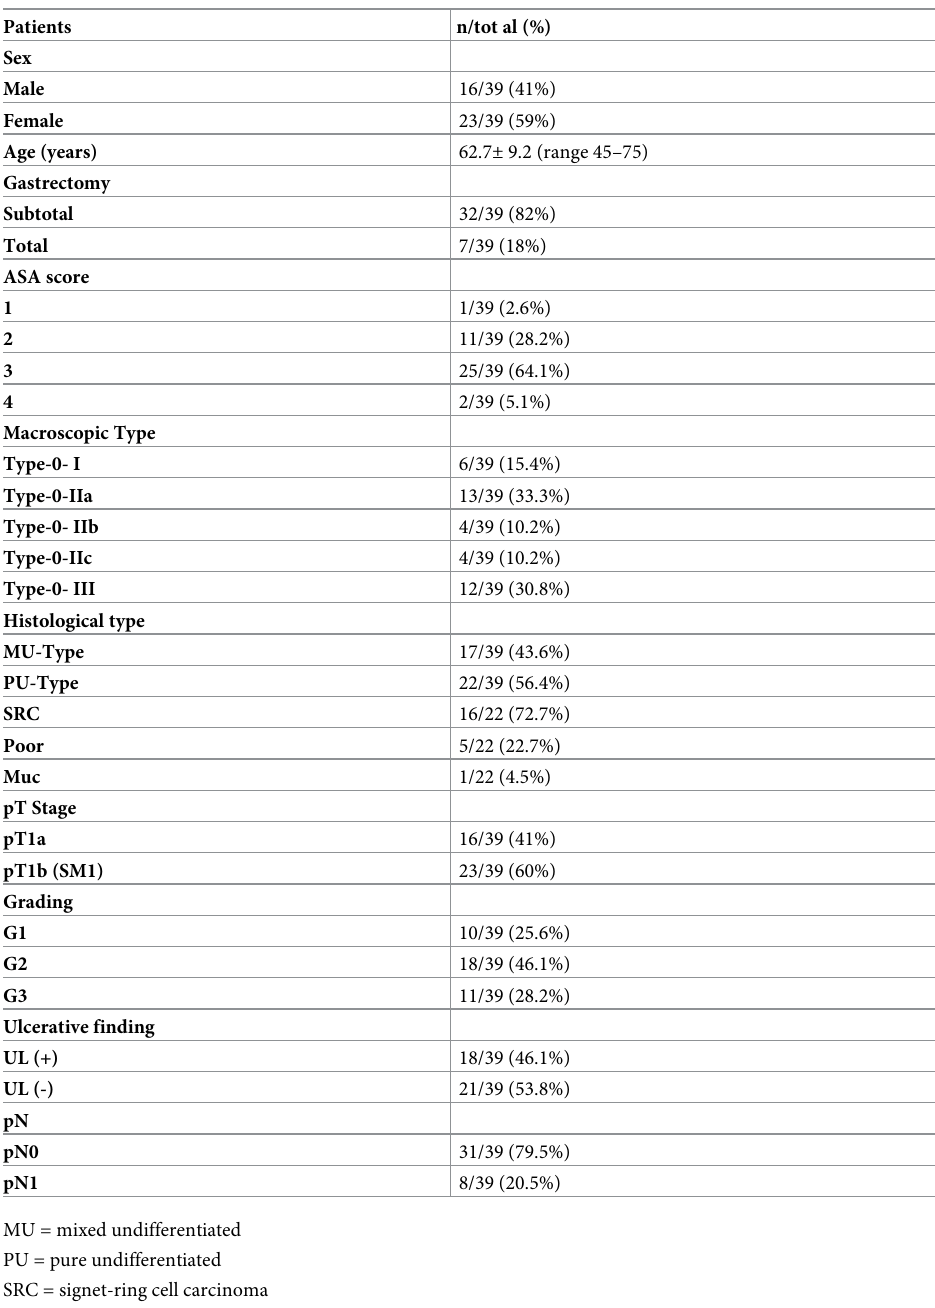
Table 1. Patient’s